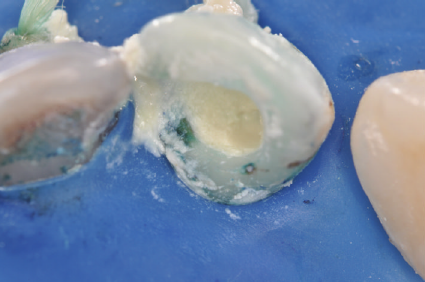
Figure 12: Root canal filling.